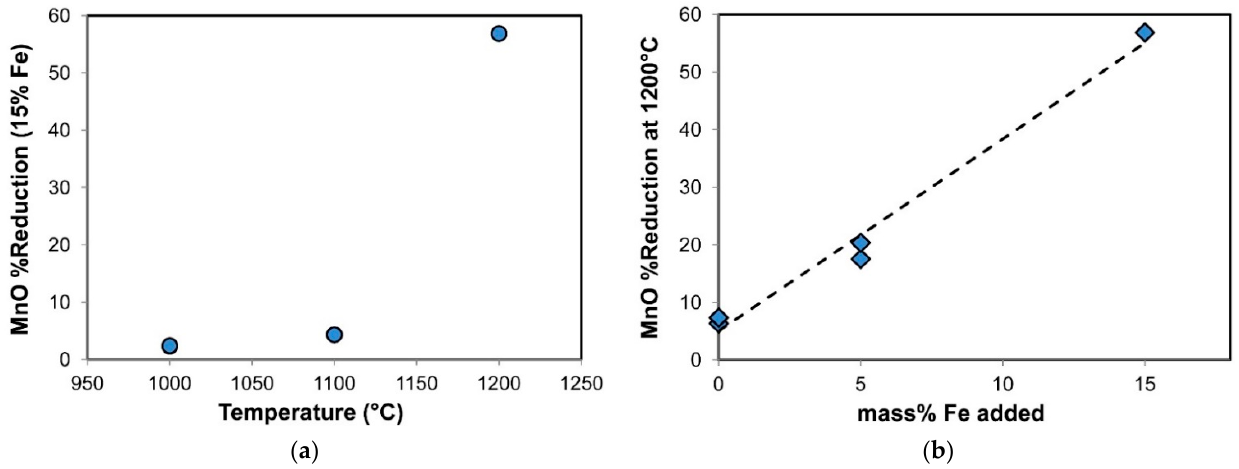
Minerals 2021 , 11 , x FOR PEER REVIEW 5 of 15 3. Results The results in Figure 2a confirm that limited MnO reduction occurred at 1000 and 1100 °C, as compared to 1200 °C. The trend of increased reduction extent with increased Fe addition is shown in Figure 2b for a 1200 °C reaction temperature. The reaction time at the temperature was 60 min for each sample. Reduction rate data from this work and from the literature are compared in Figure 3. The reduction data from this study was translated to reduction rate numbers by assuming the MnO reduction vs. time plot follows a straight line at 1200 °C, similar to previously reported MnO reduction trends at low temperatures [12,17]. The rates are presented as a function of iron content in ores and MnO-C mixtures reacted at intermediate temperatures of 1000 − 1350 °C. All the studies reported %Reduc- tion vs. time information based on the %Reduction calculated from mass loss measure- ments, assuming only CO evolved from the reduction reactions. It is seen that the reduc- tion rate values from this work (blue filled diamond icons) correspond to the work of Kim and Jung [17], yellow filled triangles, for similar experiments done at 1300 °C for pure